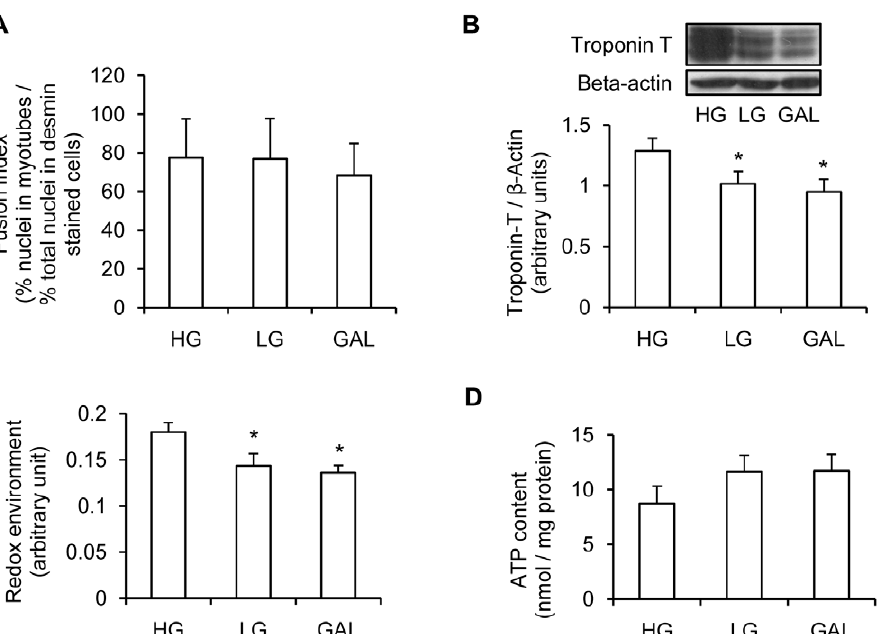
Figure 1. Effect of replacing a glucose medium with a galactose medium on myotube differentiation, redox environment and ATP content. A. Fusion index was measured in myotubes differentiated in HG (25 mM glucose), LG (5 mM glucose) or GAL (10 mM galactose) media for 7 days. The fusion index has been measured as the number of nuclei in differentiated myotubes ( . 2 myonuclei) as the percentage of the total number of nuclei in muscle cells (determined by a desmin immunofluorescence staining). Data are shown as mean 6 SEM, n=3. B. Myotube differentiation was assessed by Troponin T expression after 7 days of differentiation in HG (25 mM glucose), LG (5 mM glucose) or GAL (10 mM galactose) media. Top panel: representative Western blot of Troponin T expression in myotubes differentiated for 7 days in HG (25 mM glucose), LG (5 mM glucose) or GAL (10 mM galactose). Beta-actin was used as a loading control. Bottom panel: quantification by densitometry of Troponin T expression. Results are normalized to beta-actin expression. Data are shown as mean 6 SEM, n=4. *, p , 0.05, LG and GAL vs HG. C. Myotube redox environment in response to differentiation in HG (25 mM glucose), LG (5 mM glucose) or GAL (10 mM galactose) was assessed using the MTT assay as described in the Methods section. Data are presented as mean 6 SEM, n=3, in which each condition was assessed in 6 replicates. D. ATP content in myotubes differentiated for 7 days in HG (25 mM glucose), LG (5 mM glucose) or GAL (10 mM galactose). Results are presented as means 6 SEM, n=4, in which each condition was assessed in